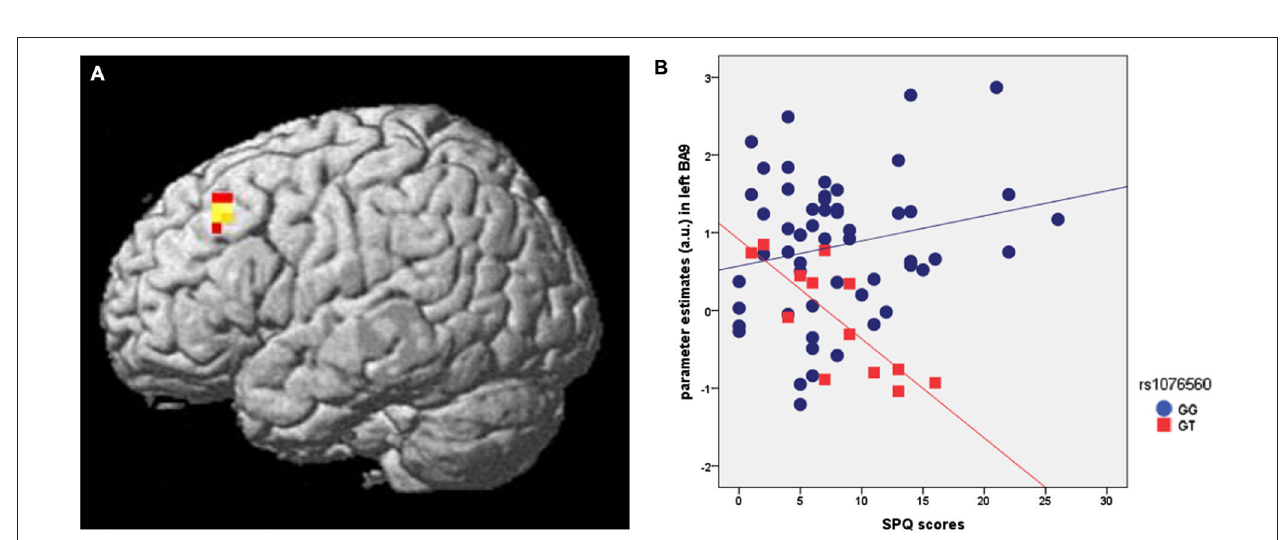
FIGURE 1 | (A) Axial section of the brain showing the interaction between rs1076560 and SPQ scores on IBZM binding V3 (cid:48)(cid:48) in the right putamen. (B) IBZM binding V3 (cid:48)(cid:48) extracted from the right putamen cluster illustrated in (A) .